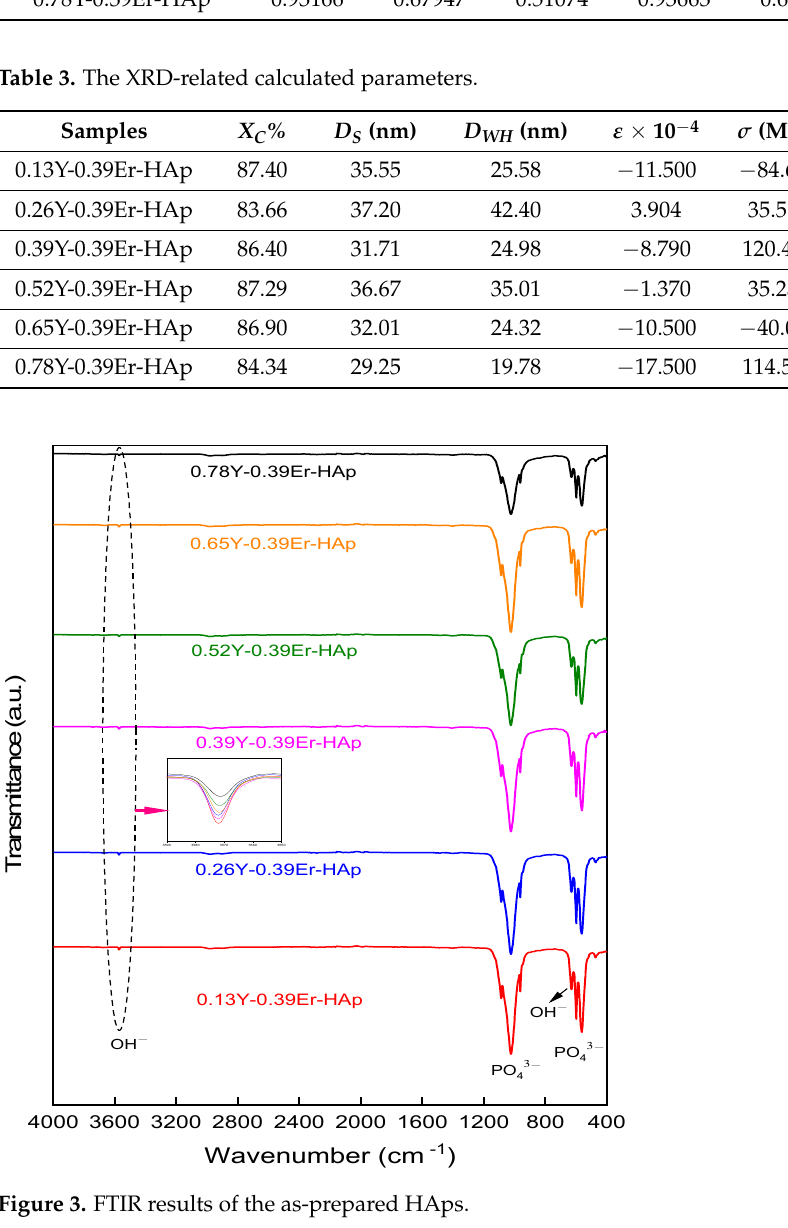
Table 2. The comparison of theoretical and experimental values of the lattice parameter and unit cell volume.